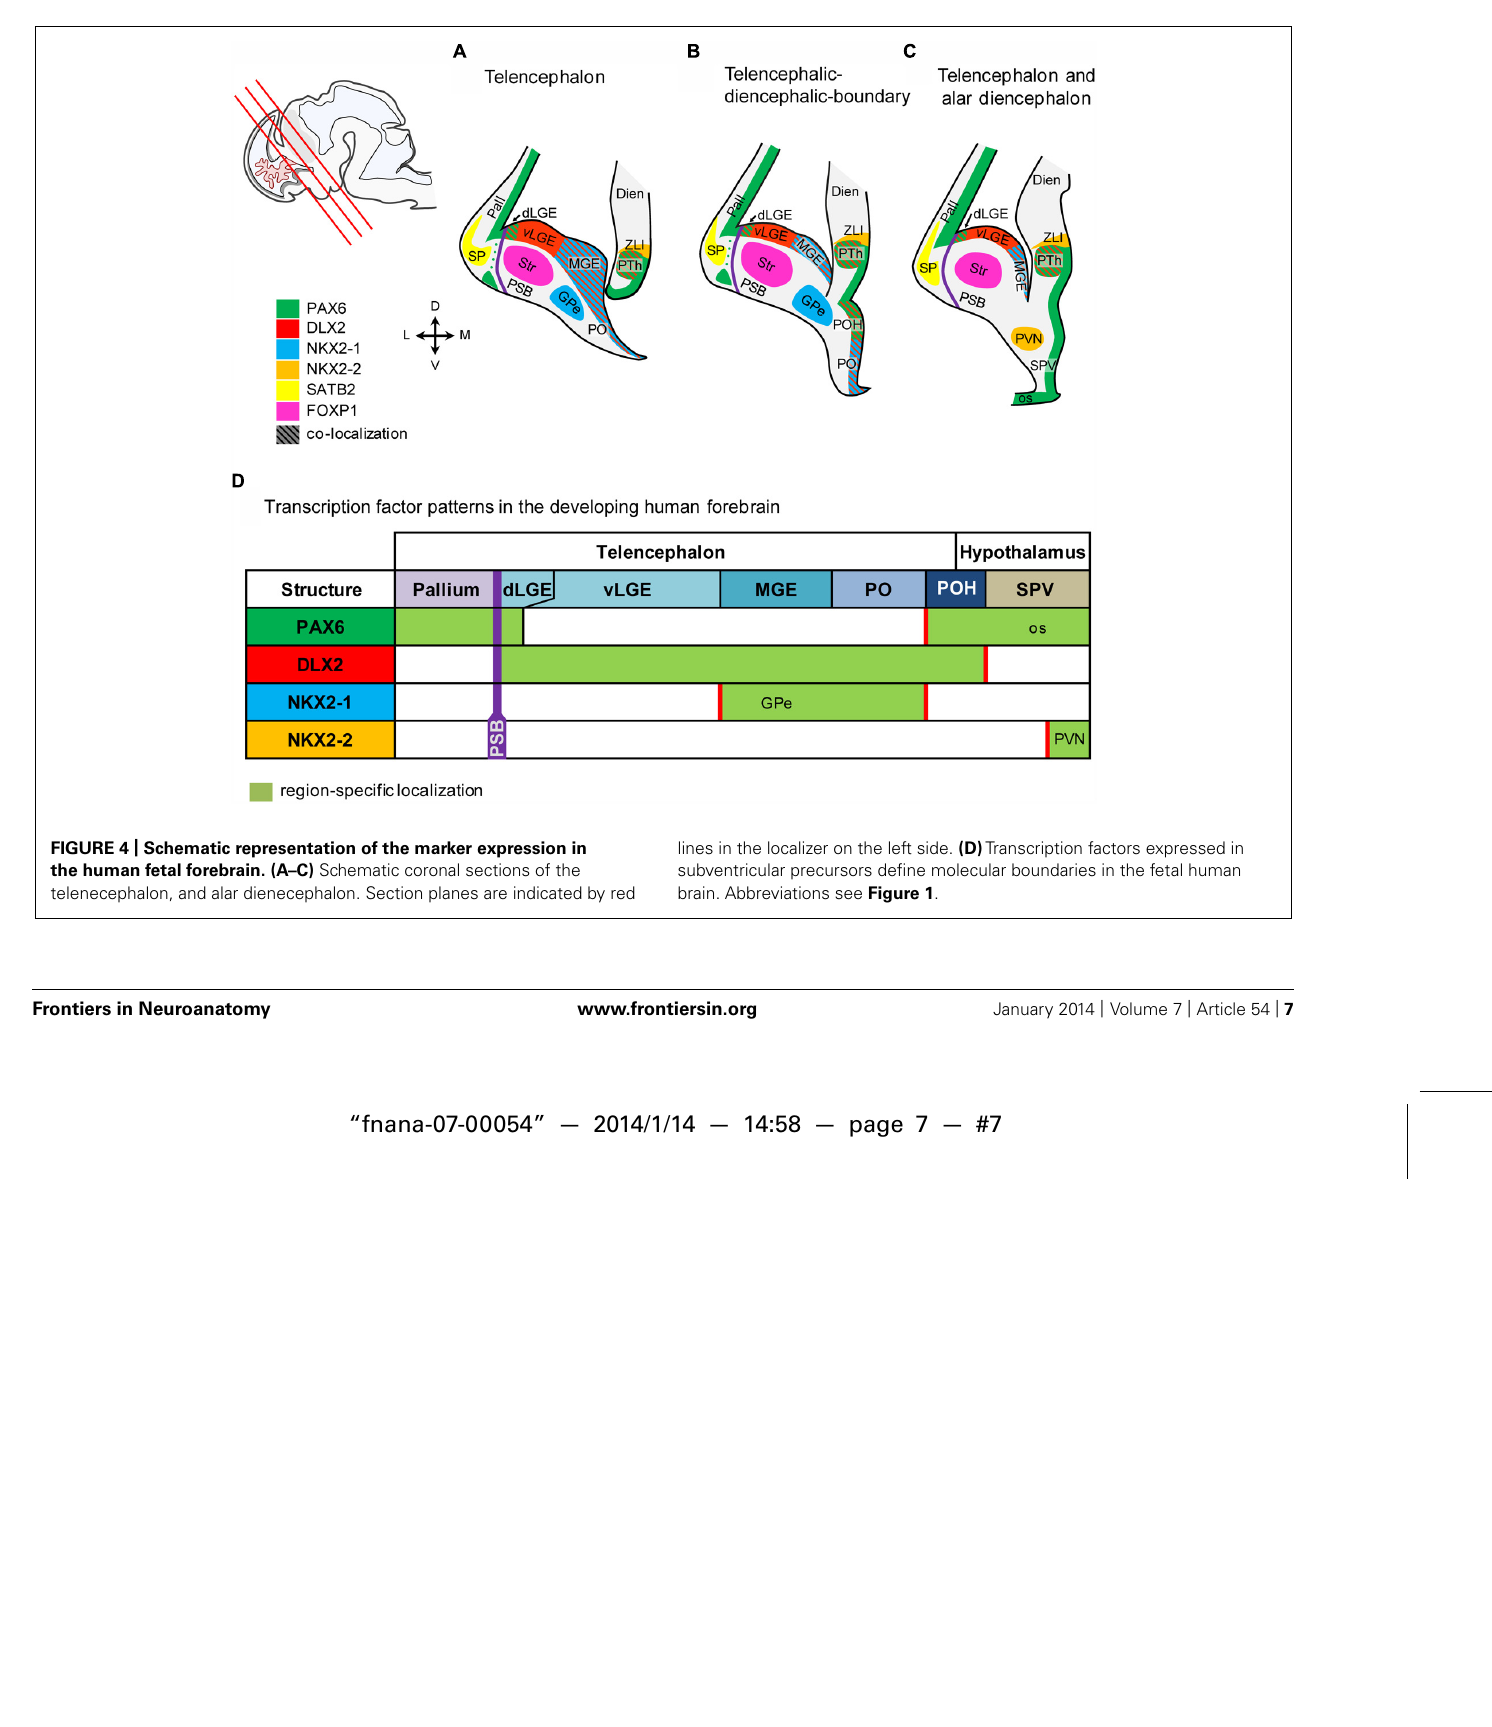
FIGURE 4 | Schematic representation of the marker expression in the human fetal forebrain. (A–C) Schematic coronal sections of the telenecephalon, and alar dienecephalon. Section planes are indicated by red